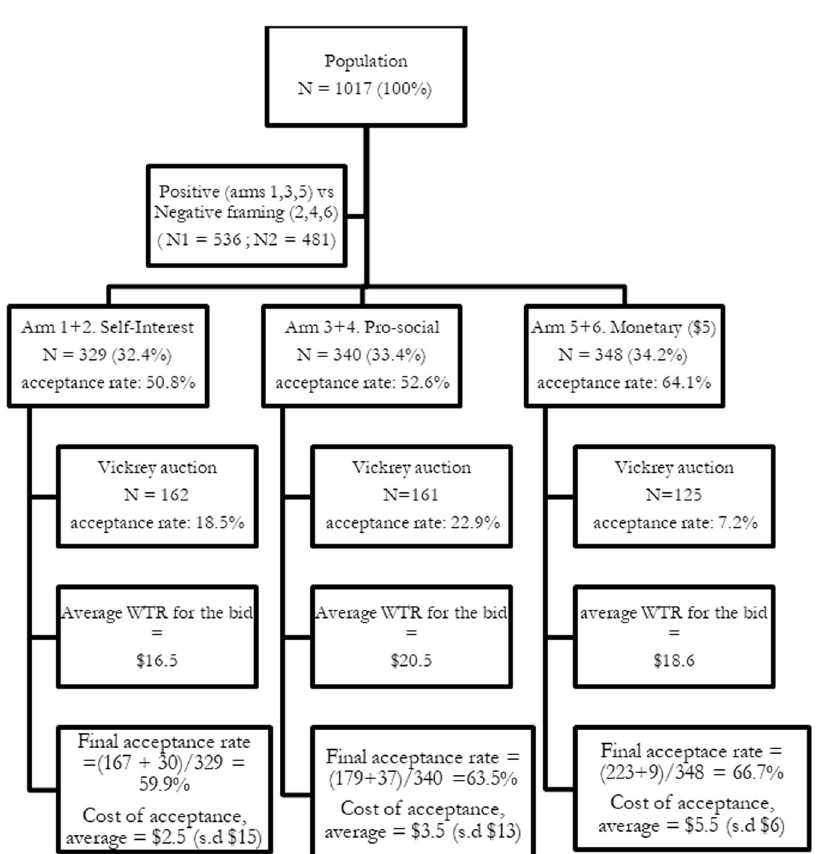
Fig. 2 Randomization of three different arms of the study: Chart of participants in each study